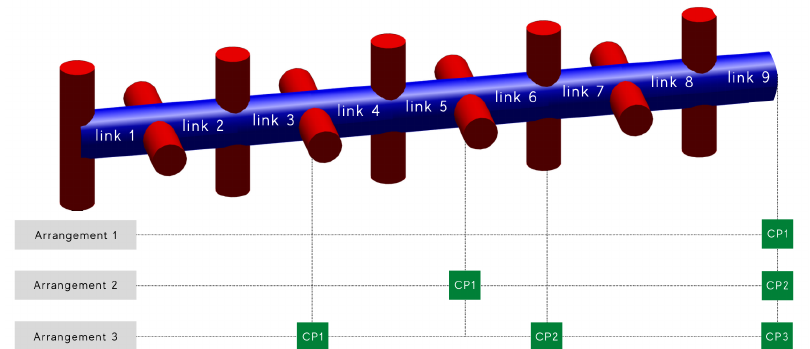
Figure 4. The three arrangements of the control points (CP’s) along the robot’s kinematic chain. In the first arrangement, only one control point was used which was placed at the end effector. In the second and third arrangements, two and three equally spaced control points were used, respectively.